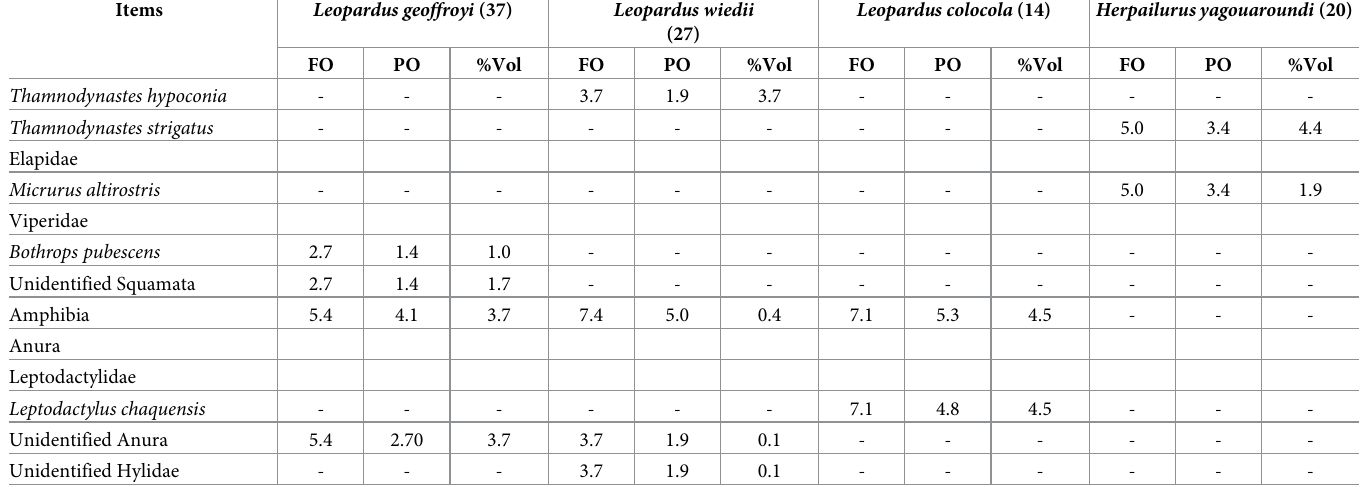
observed here occurring with Geoffroy’s cat, margay, and pampas cat (Table 2). In this work, higher diversity of taxa. This apparently paradoxical result occurs because margay consumes while others just occasionally.